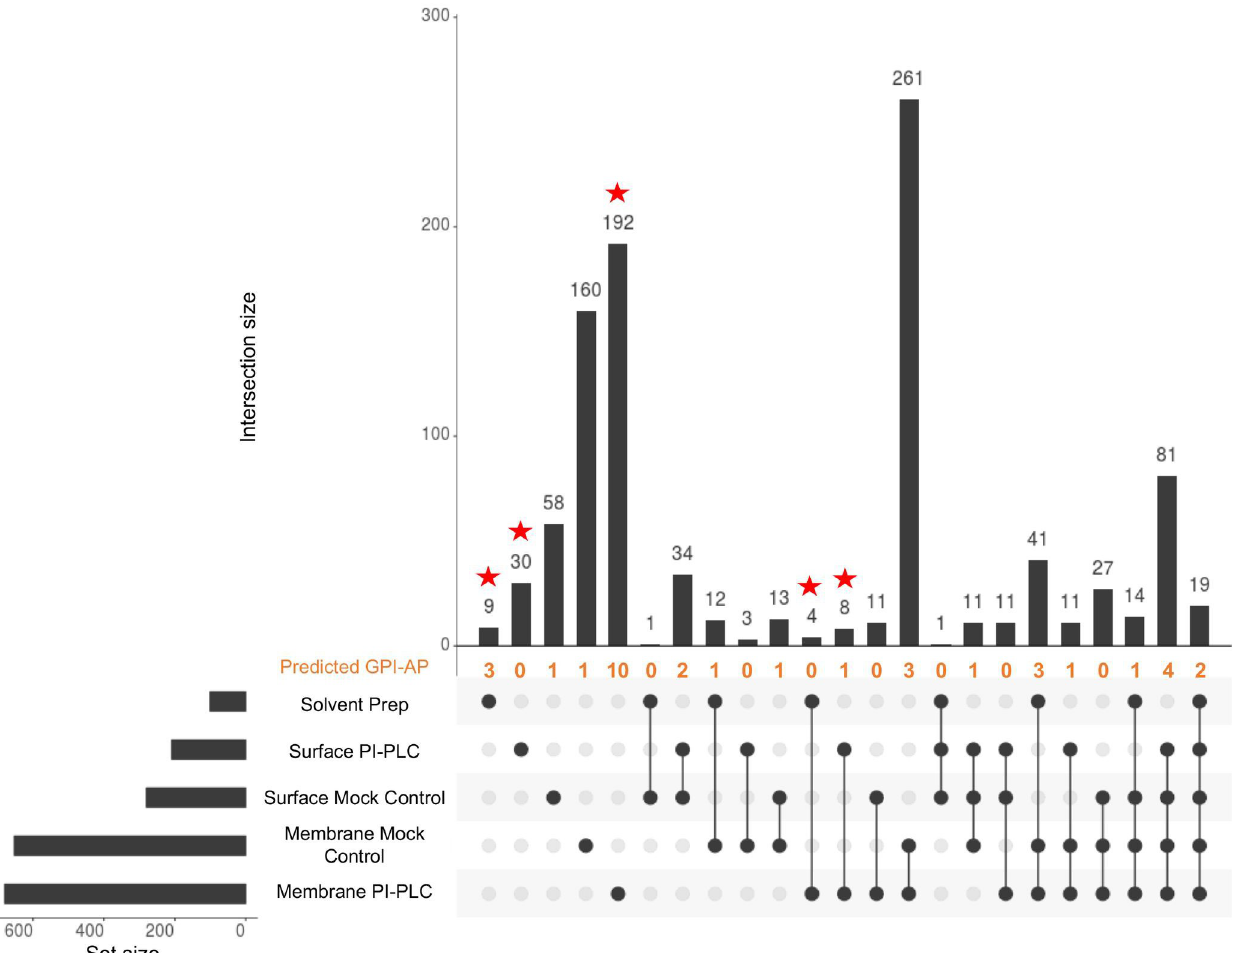
Fig 4. UpSetR data analysis of LC-MS/MS data from the five protein samples. Membrane Enrich: sample from membrane preparation that was enriched for GPI-APs using successive organic solvent partitioning; Surface PI-PLC and Surface Mock Control : released proteins from intact worms treated with PI-PLC or no enzyme; Membrane Mock Control and Membrane PI-PLC: released proteins from membrane preparation treated with no enzyme or PI-PLC. Starred columns represent sets only containing proteins from experimentally GPI-AP enriched samples. The number of predicted GPI-APs found in each dataset is indicated in